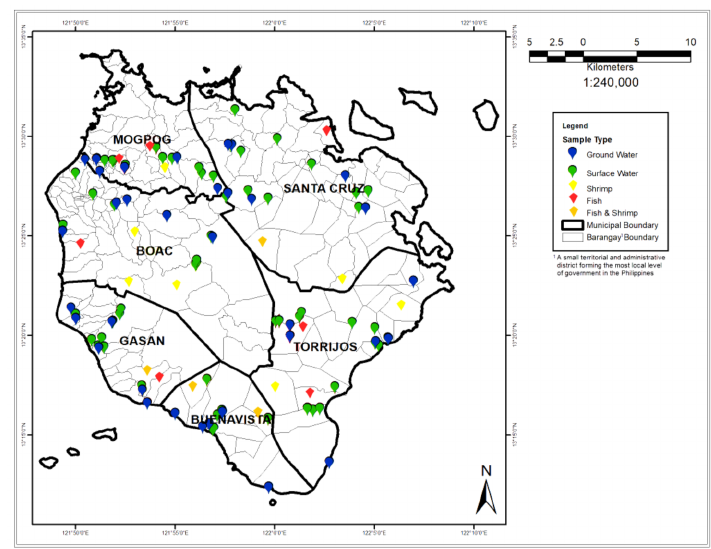
Figure 1. Map of the study area and location of sampling